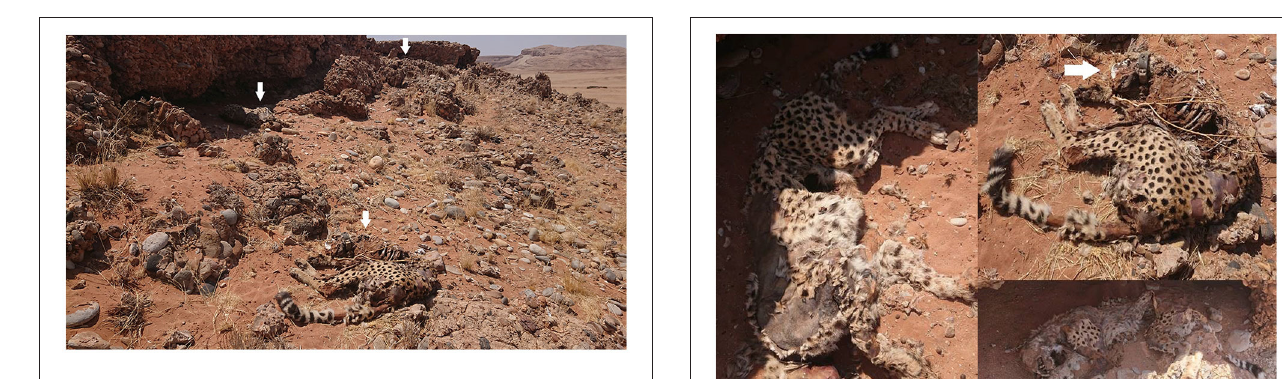
FIGURE 1 | Two of the three cheetah male carcasses (left and middle arrow) as found 11 days after they died. The carcass of the third animal was found approximately 10 meters away behind a rock (right arrow).